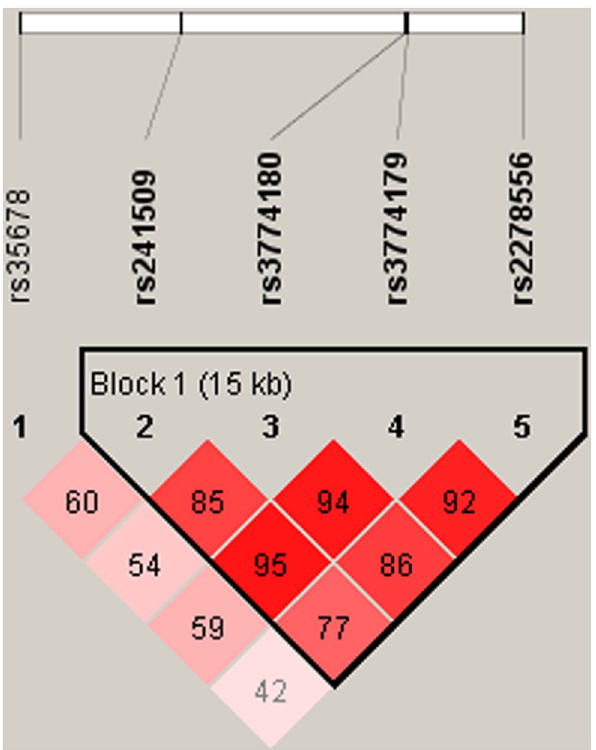
Figure 1. Linkage disequilibrium (LD) block constructed from 5 SNPs in ATP2B2 . Markers with Linkage disequilibrium (LD) ( D’ , 1 and LOD . 2) are shown in red through pink (color intensity decreases with decreasing D’ value). D’ value shown within each square represents a pairwise LD relationship between the two polymorphisms. D prime values of 1.0 are never shown (the box is empty). The LD plot was generated with the Haploview program.